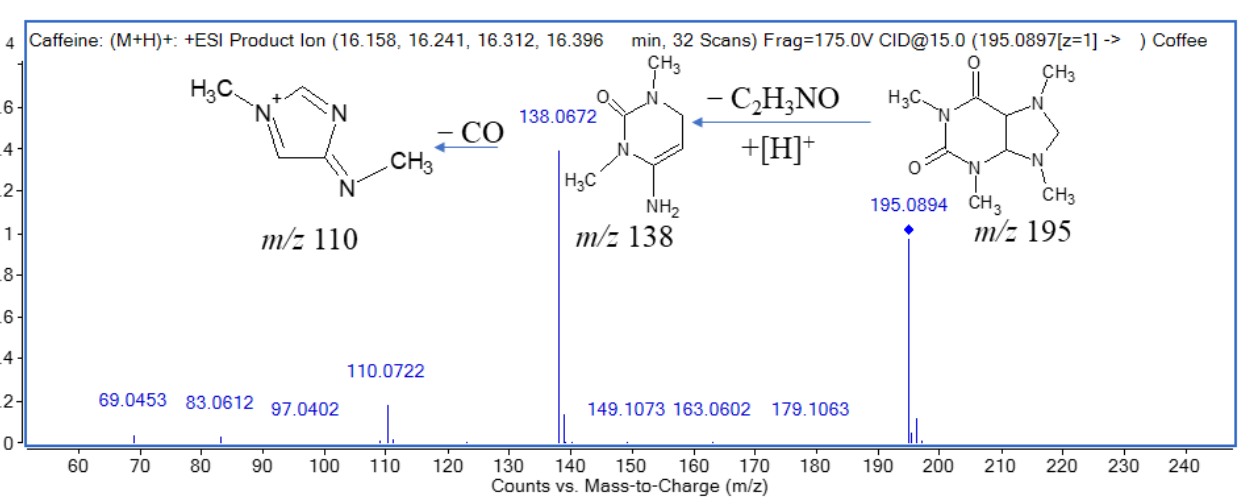
Figure 1. LC-MS/MS identification of caffeine in ESI + mode and proposed fragmentation pattern of caffeine at m/z 195.